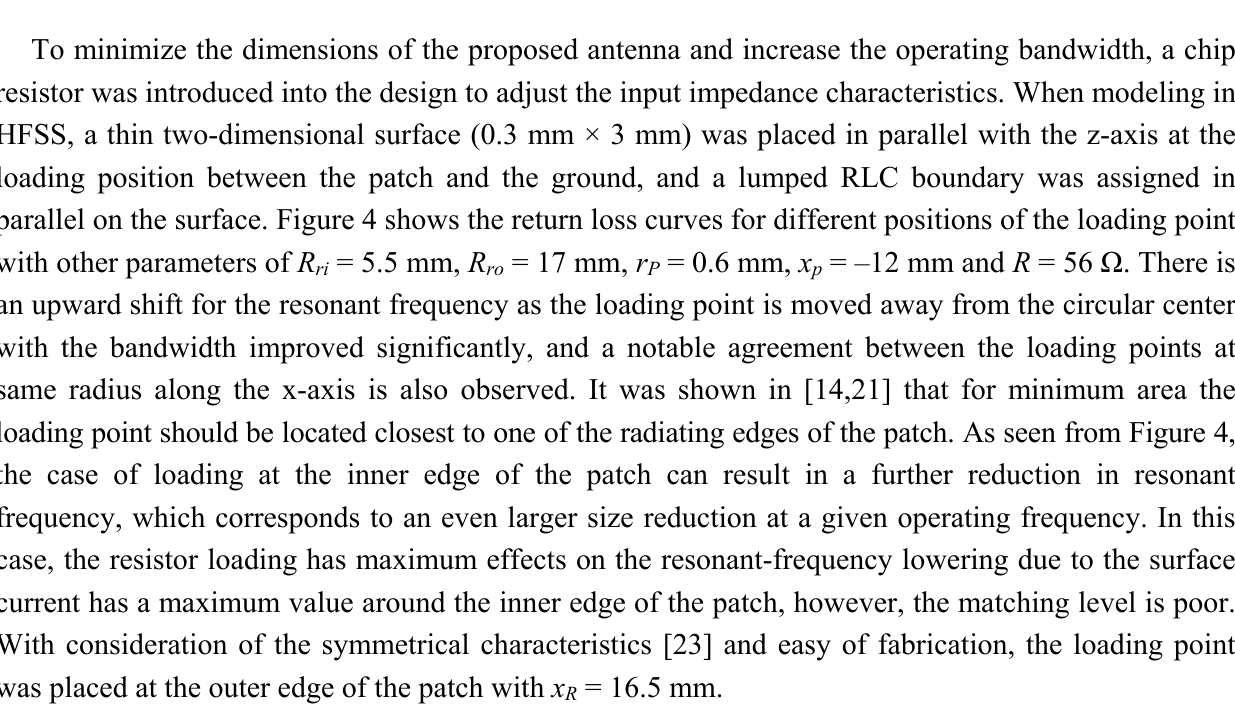
Figure 4. Simulated return loss curves with different values of x